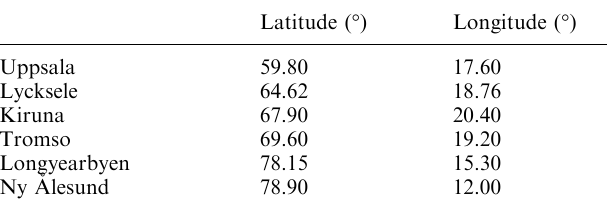
Table 1. Geographic coordinates of satellite receiving